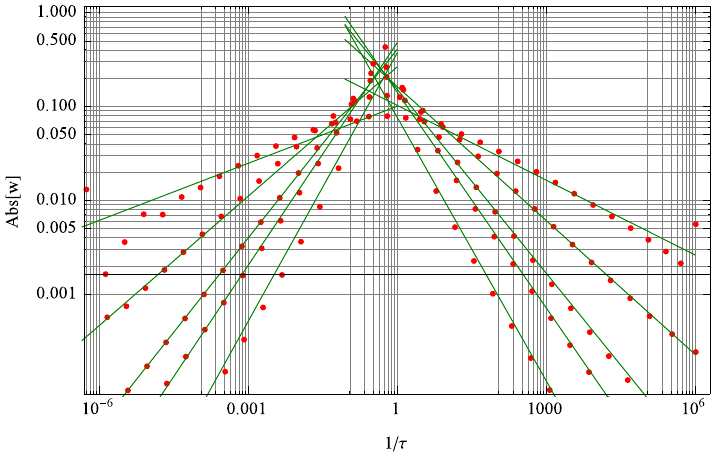
Figure 11. Scaling regions of the weights w 40 exponentials and parameter values u and n = 51 . The upper lines correspond to q = 1 = 3 while the lower line is assigned to q = 8 = 9